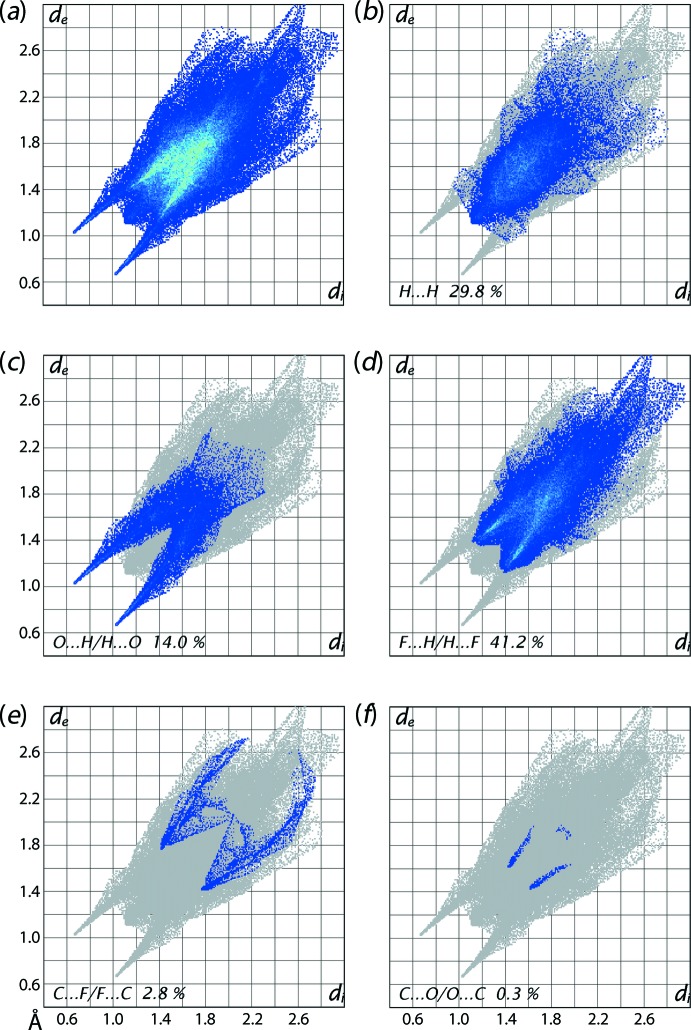
(a) The full two-dimensional fingerprint plot for (I) and (b)–(f) those delineated into H⋯H, O⋯H/H⋯O, F⋯H/H⋯F, C⋯F/F⋯C and C⋯O/O⋯C contacts, respectively.